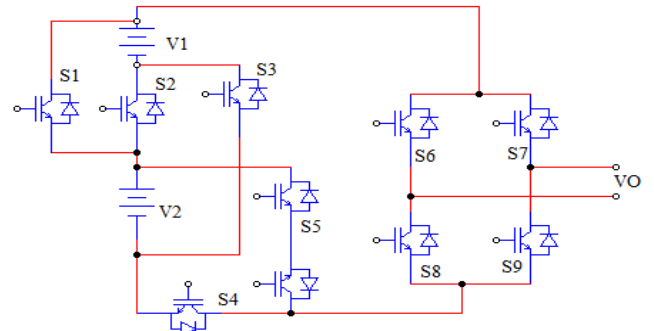
Figure 6. Nine-ten-switch, 9-level topology Figure 6. nine-ten-switch, 9-level topology [55].